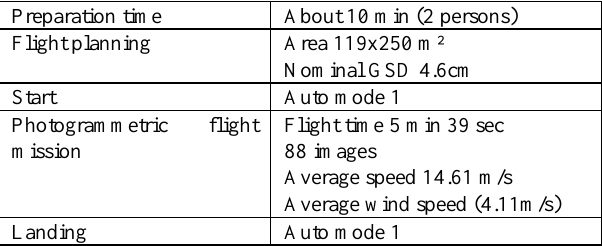
Table 2: Flight parameters (BezF6, June 8th 2010).